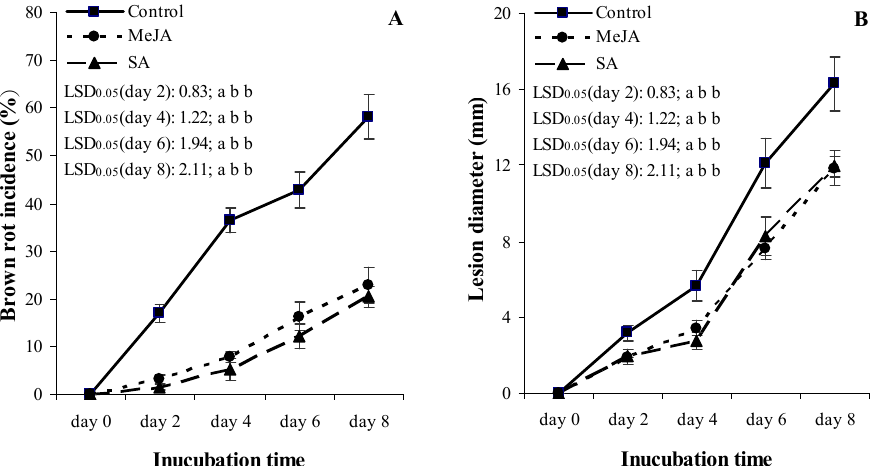
Figure 1. Effect of 2 mmol L − 1 salicylic acid (SA) and 0.4 mmol L − 1 methyl jasmonate (MeJA) on brown rot incidence (%) ( A ) and on lesion diameter (mm) ( B ) of apricot fruit (cv. ‘Bergarouge’) inoculated with Monilinia laxa assessed at days 0, 2, 4, 6 and 8 after treatment began. Standard deviation values are presented by bars. Control refers to fruits treated with distilled water. Differences among the control, MeJA, and SA treatments are represented by LSD 0.05 values at p < 0.05. Values within the given days coupled with different letters are significantly different among the water-treated control, MeJA, and SA treatments at p = 0.05 according to LSD t -tests. After each LSD 0.05 value, the first, second, and third letters belong to control, MeJA, and, SA treatments, respec- tively. Fruits showed no brown rot symptoms in non-inoculated treatments; therefore, these data were